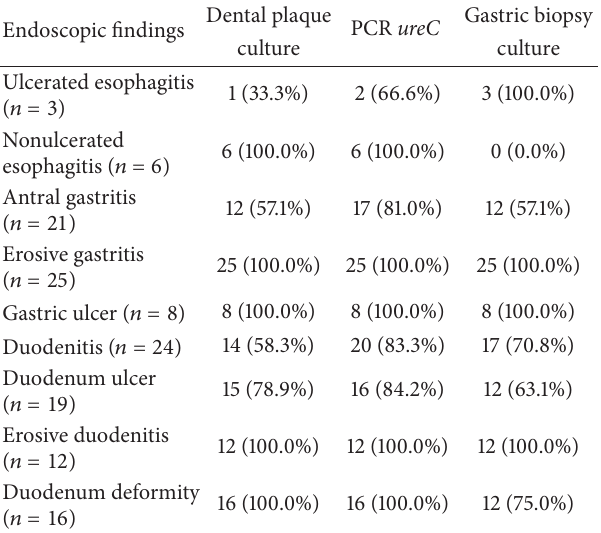
Table 2: Relationship of endoscopic findings and H. pylori preva- lence in dental plaque and gastric biopsy’s dyspeptic